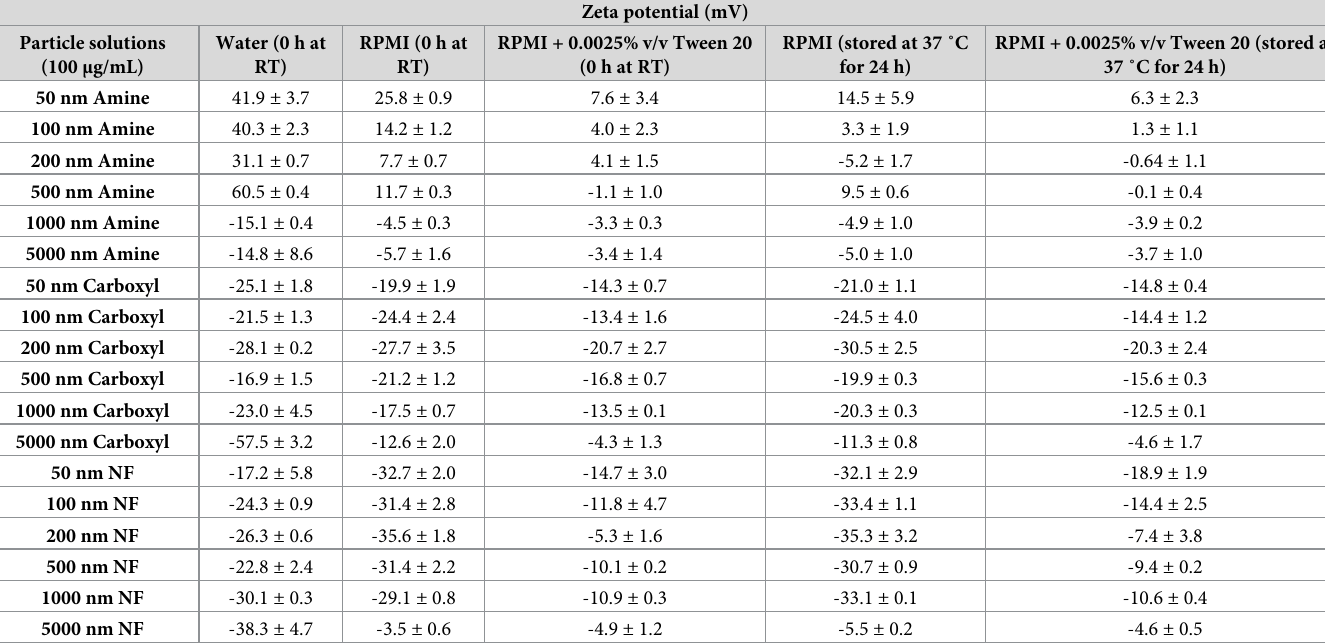
Table 3. Zeta potential of polystyrene micro/nanoplastics under various conditions (mean ± S.D.; n =